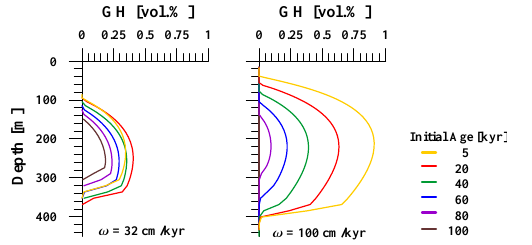
Fig. 9. Sensitivity analysis of the standard model: For each model Figure 9. Sensitivity analysis of the standard model: For each model run (red dots) only one run (red dots) only one input parameter was varied. Additionally, input parameter was varied. Additionally, the output parameter SO 4 -CH 4 -transition depth the output parameter SO 4 -CH 4 -transition depth (SMT) as a result of increasing the POCar is (SMT) as a result of increasing the POCar is shown.